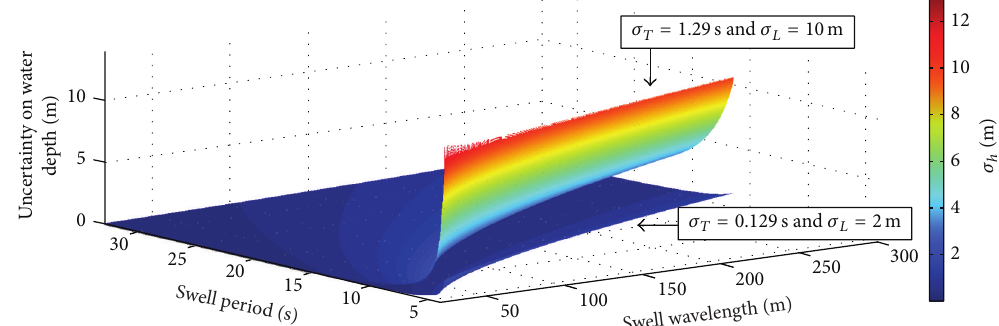
Figure 8: Uncertainty in the estimated water depth in the considered admissible (𝐿,𝑇) area for the minimum and maximum values for both 𝜎 𝜎 𝑇 and 𝐿 .